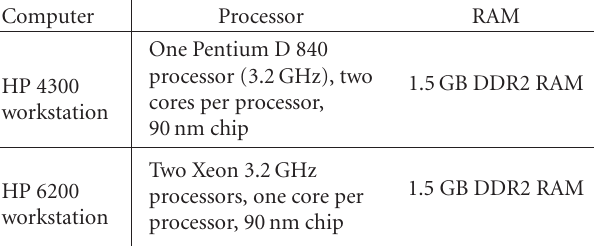
Table 1: Configurations of the host